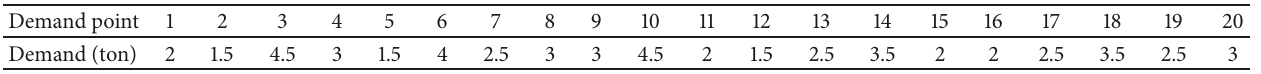
Table 1: Customer demands.